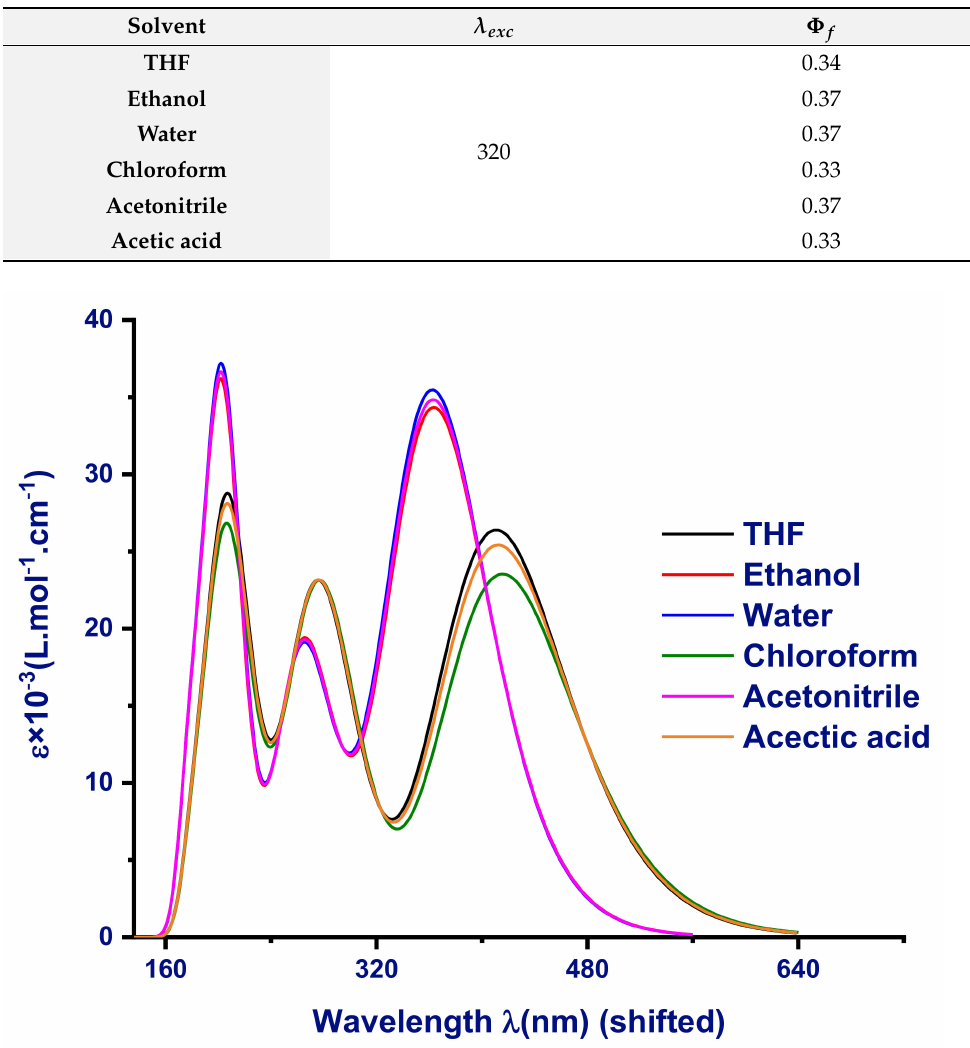
(cid:16) (cid:17) Φ at f